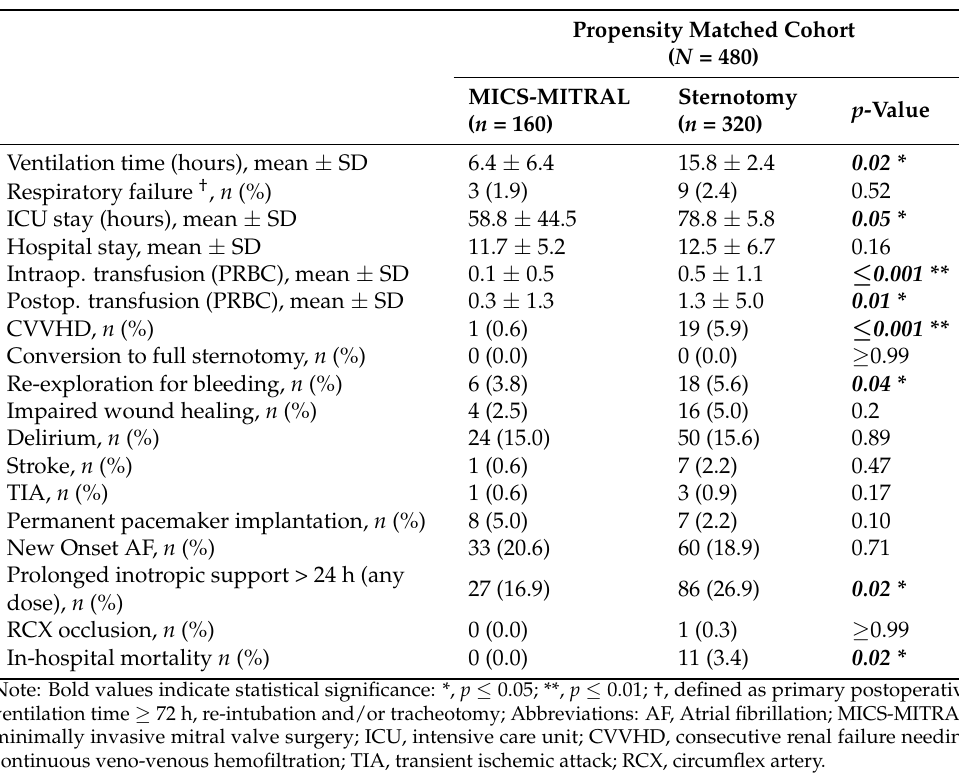
Table 6. Postoperative procedural-related complications.